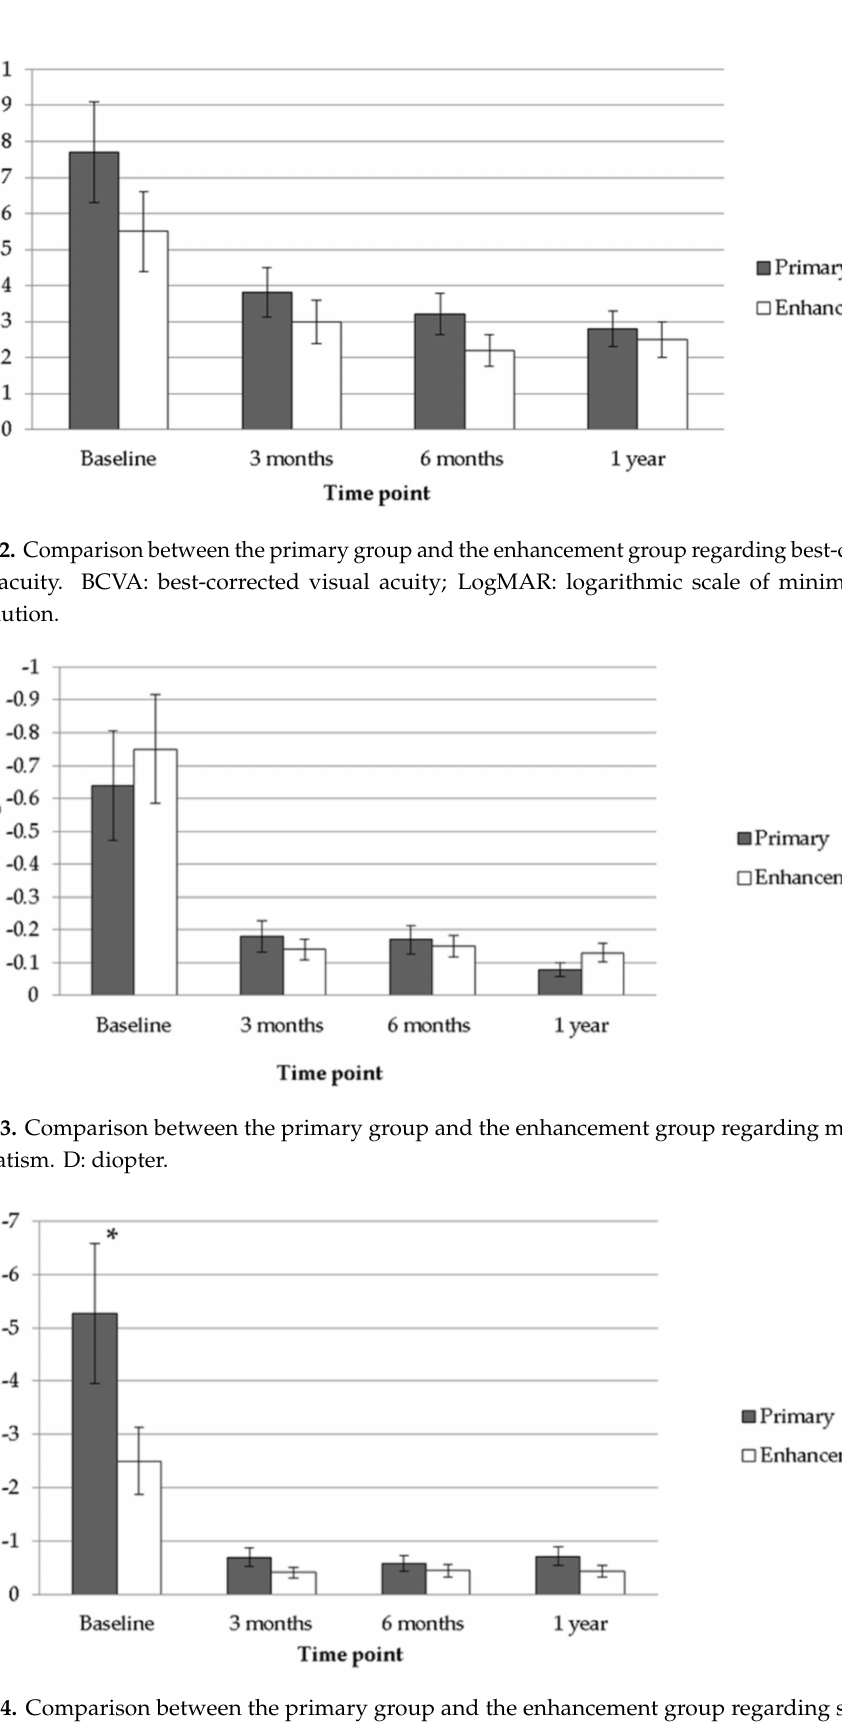
Figure 4. Comparison between the primary group and the enhancement group regarding spherical equivalent. SE: spherical equivalent; D: diopter; * denotes significant di ff